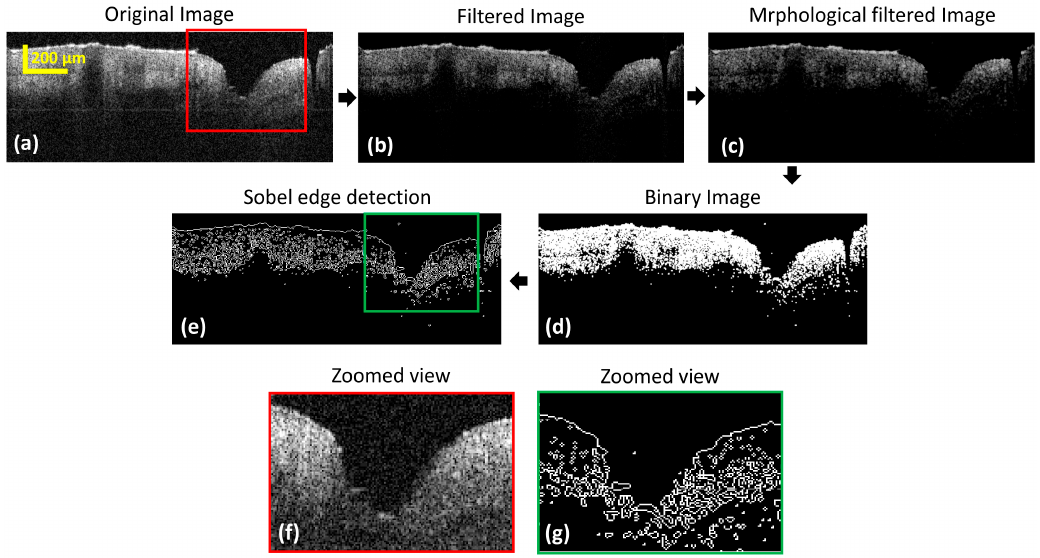
Figure 2. Skin sebum-extracted OCT images with the precise detection of the edges.